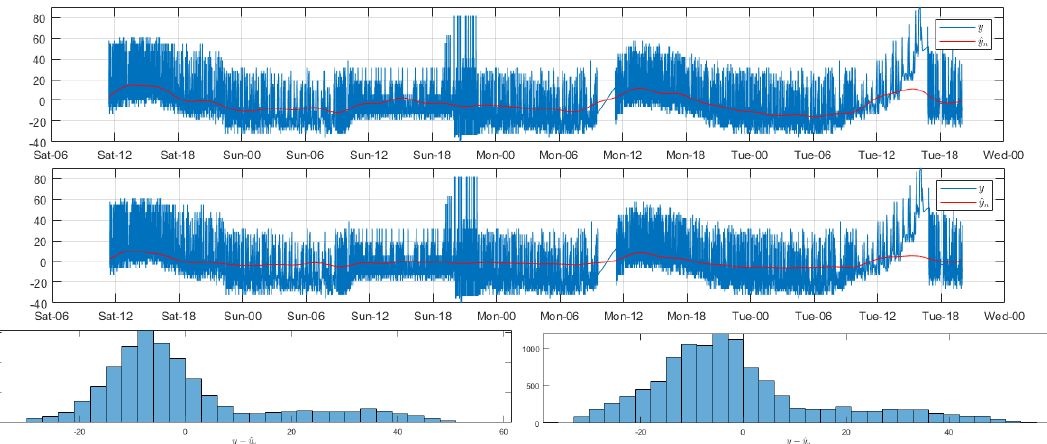
Figure A2. Modeling the CO 2 signal in Sensor Node 4 of DigiMesh network ( Ord = 0). From top to bottom: Rhythmometric analysis with Reg = 10 and Reg = 10,000, and histograms for their corresponding residuals (left and